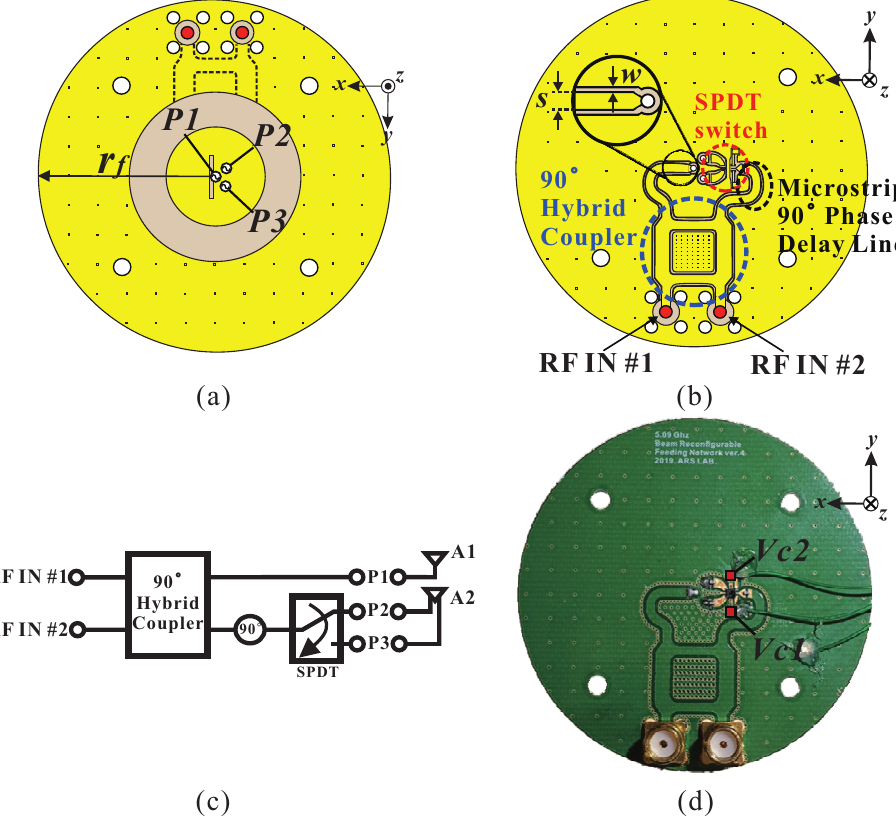
Figure 3. Configuration of proposed the feeding network and its fabricated prototype: ( a ) top view of the multi-antenna and feeding network, ( b ) bottom view of the multi-antenna and feeding network, ( c ) the proposed feeding network for four beam pattern using power dividing, and ( d ) phase differences and bottom view of the fabricated multi-antenna and feeding